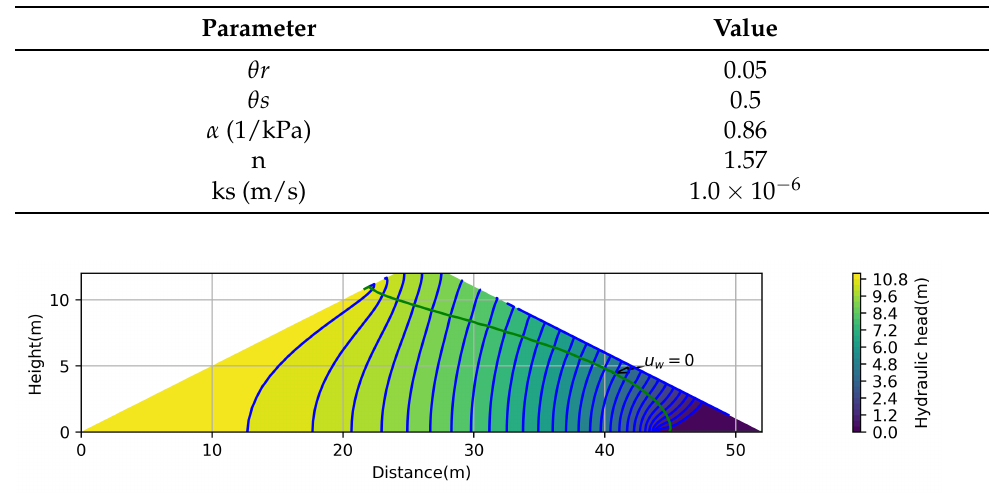
Table 2. Soil parameters used in the simulation.